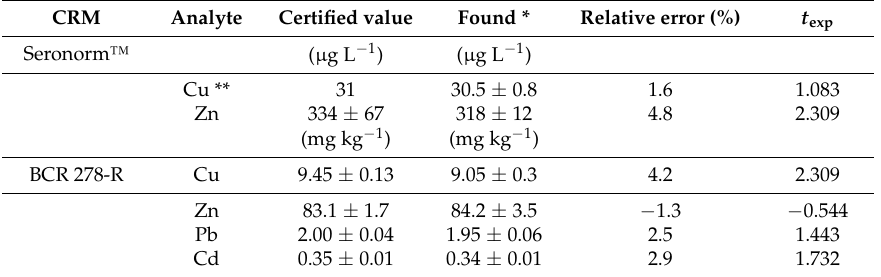
Table 3. Applications of the developed FI-FDSE-FAAS method in CRMs for metal determination. CRM Analyte